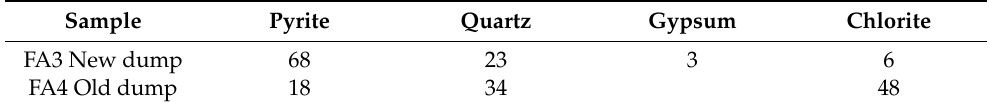
Table 1. Semi-quantitative determination of mineralogical composition of new dump and old dump (data in wt%), Grieco et al. [16].